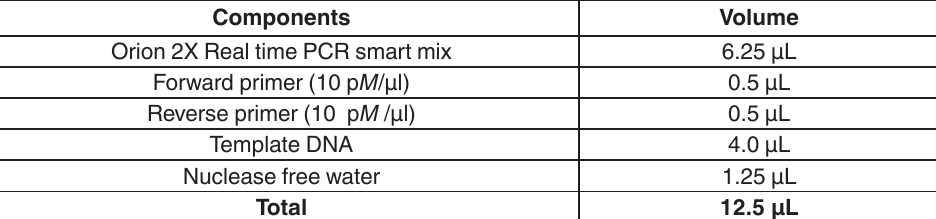
table 2. Real-time PcR Reaction mix for the detection of Campylobacter foetus subsp. foetus and Campylobacter foetus subsp. venerealis